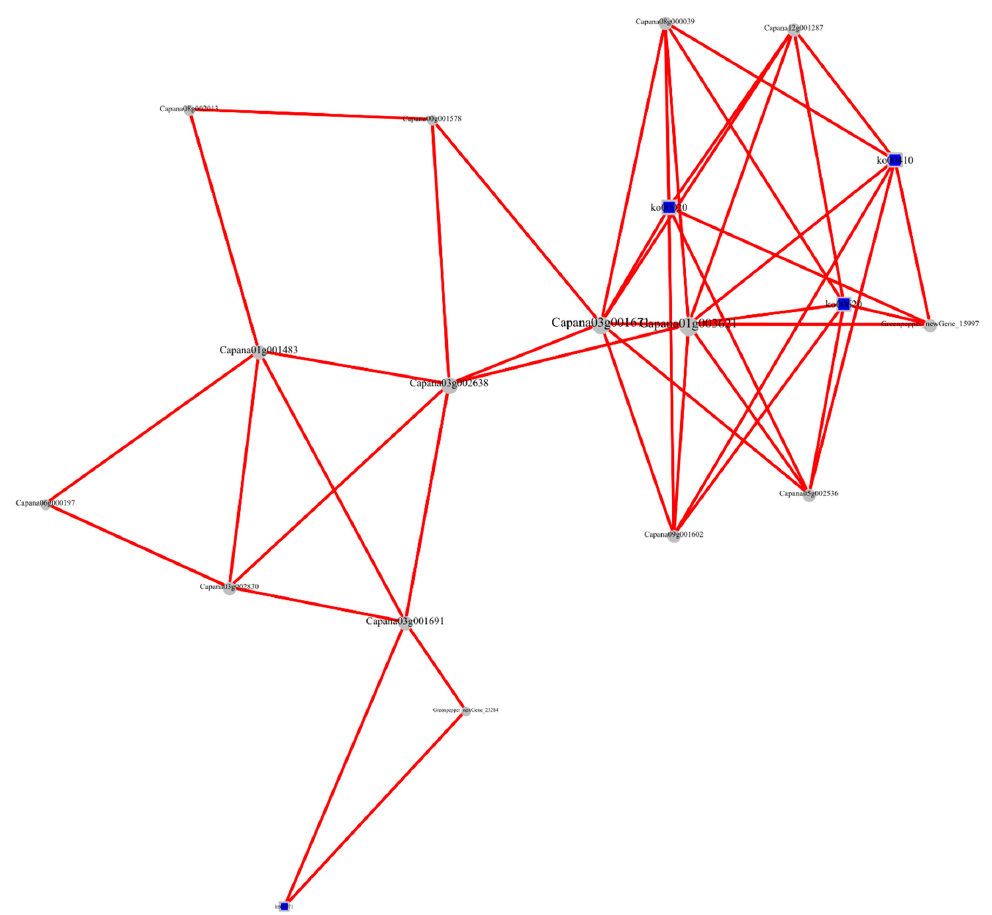
Figure 6. Pathway network from the annotation of the key genes. The key genes in the pathway are involved in lipid transport and metabolism, which play an important role in the chilling stress process.